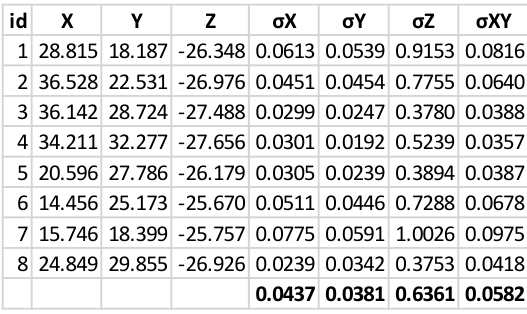
Figure 3. Typical results from one of the ten trilateration adjustments. The error eclipses are scaled ten times. The standard errors in Z (green vertical lines) are significantly larger than X and Y ones.